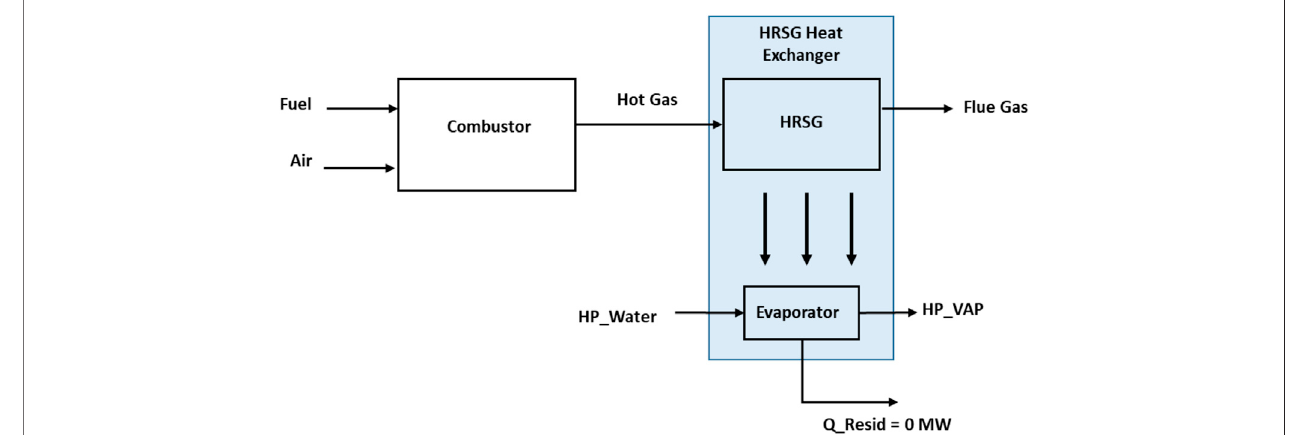
FIGURE 5 | The boiler energy